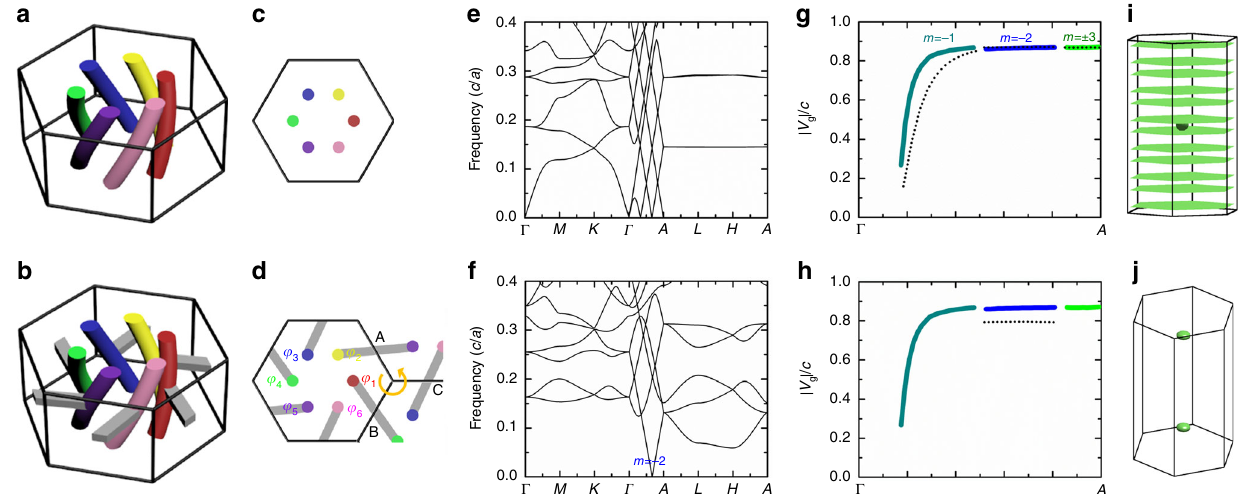
Fig. 3 Selection of modes with different angular momenta through the introduction of in-plane connection. a Hexagonal array of isolated helical wire bundles. b Wire bundles (colored) with in-plane connecting bars (gray) that pass through the unit cell corner. The colors in a and b just highlight different helical wires. These helical wires do not necessarily have independent potentials, which depend on the connection con fi guration. c , d Corresponding cross- sectional views. e , f Band structures. g , h Group velocities of the linear bands emerging from the quasistatic modes (black dotted lines). For comparison, the group velocities of the guided modes in helical wire bundle shown in Fig. 2c are plotted using colored lines. Colors indicate different angular momentum m . i , j Equifrequency surfaces showing index ellipsoids or planes at different k -points. For the structure in a , as the wire bundles in different unit cells are isolated, the system has an in fi nite number of independent potentials and thus an in fi nite number of quasistatic modes with arbitrary ( k x , k y ) and discretized k z = − m β . These quasistatic modes can be interpreted as transmission-line modes propagating in the z -direction, corresponding to the fl at surfaces in i . After introducing an in-plane connection, the system has a fi nite degree of freedom and forms index ellipsoids at speci fi c k -points depending on the connection con fi guration. The in-plane connection in b fi ltrates out the quasistatic modes with m = ± 1, ± 3, leaving two index ellipsoids located at ð 0 0 ± 2 π = 3 d Þ , see ( j the structure shown in Fig. 3b, we add six horizontal metallic bars (gray), see also the cross-sectional view in Fig. 3d. The potentials of the 6 bars are φ 1 to φ 6 . The corresponding band structure calculated by COMSOL is plotted in Fig. 3f. Comparing the results in Figs. 3f and 2c, one fi nds that the 3D metamaterial in Fig. 3f only supports quasistatic modes at k z = ± 2 π /3 d rather than fi ve quasistatic modes in the one-dimensional bundle shown Fig. 2c. This is due to the periodic boundary condition imposed by the horizontal metallic bars on any pair of wires related by inversion symmetry (e.g., the red and green wires are connected via Bloch boundary condition). This in-plane connection imposes further requirements on the Bloch k and the angular momentum m , forbidding those with m = ± 1, ±3. For example, there are three metallic bars (labeled as A, B and C in Fig. 3d) encircling the right corner of the hexagonal cell marked by the solid line in Fig. 3d. The potential difference between bars A and B is ( φ 2 − φ 1 ). By applying Bloch theorem, the potential difference between (cid:2) φ B and C is φ 4 3